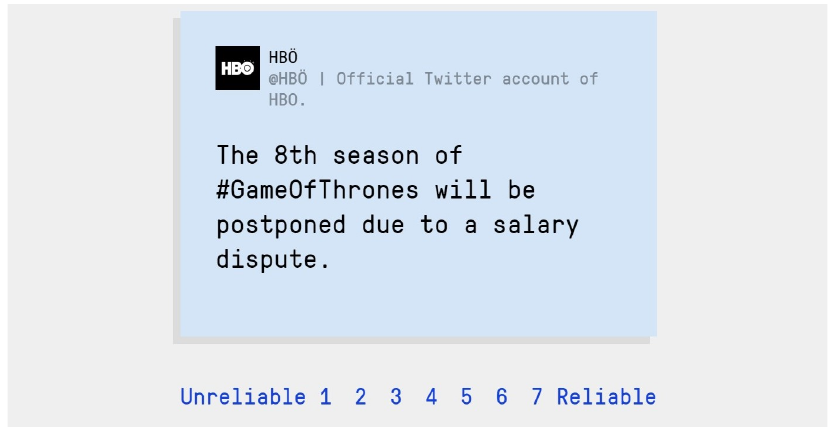
Figure 1. Example of a fake Twitter post (impersonation